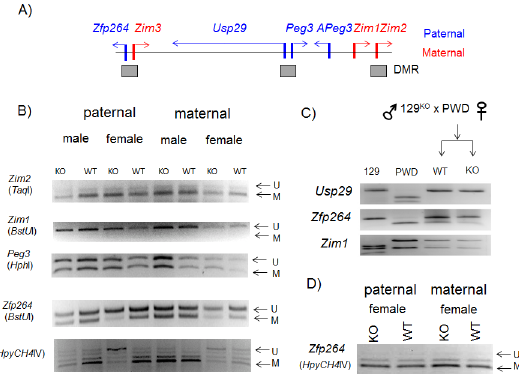
Fig 6. Mutational effects on DNA methylation levels. ( A ) Schematic representation of the Peg3 domain with three DMR (Differentially Methylated Regions). The genes with blue and red indicate paternally and maternally expressed genes, respectively. The DMRs are indicated with grey boxes. ( B ) A series of DNA methylation analyses were performed using the DNA isolated from two sets of the mice: one set inheriting the knockin allele paternally (lane 1 – 4) whereas the other set inheriting maternally (lane 5 – 8). Each set has two heterozygotes with both sexes. The DNA isolated from either tail or brain was treated with bisulfite conversion protocol, and subsequently used for the amplification of each target region. The amplified PCR product was analyzed with COBRA. The restriction enzyme used for each set of PCR products are shown underneath of the gene ’ s name. The undigested and digested DNA fragments by a given restriction enzyme are also indicated by U and M with arrows, respectively. The DNA methylation levels of the Peg3 domain were not affected by the knockin allele except the hypomethylation observed in the promoter of Zfp264 in the female heterozygotes (lane 3, 7). ( C ) RT-PCR-based imprinting test of the genes within the Peg3 domain. This series of imprinting tests used the total RNA isolated from the brain of the F1 hybrid of the female set that had been prepared through the crossing of the heterozygotes with 129/B6 background and breeding partners with PWD/PhJ background. The product from RT-PCR was digested with a given restriction enzyme to differentiate parental alleles, which are shown in different-size DNA fragments on gel images. The imprinting status of three genes did now show any difference between WT and KO mice. ( D ) COBRA analyses were also performed using the DNA isolated from the female set of WT and KO with the paternal and maternal transmission of the knockin allele. The DNA methylation levels of the promoter of Zfp264 were not affected in this set of F1 hybrid